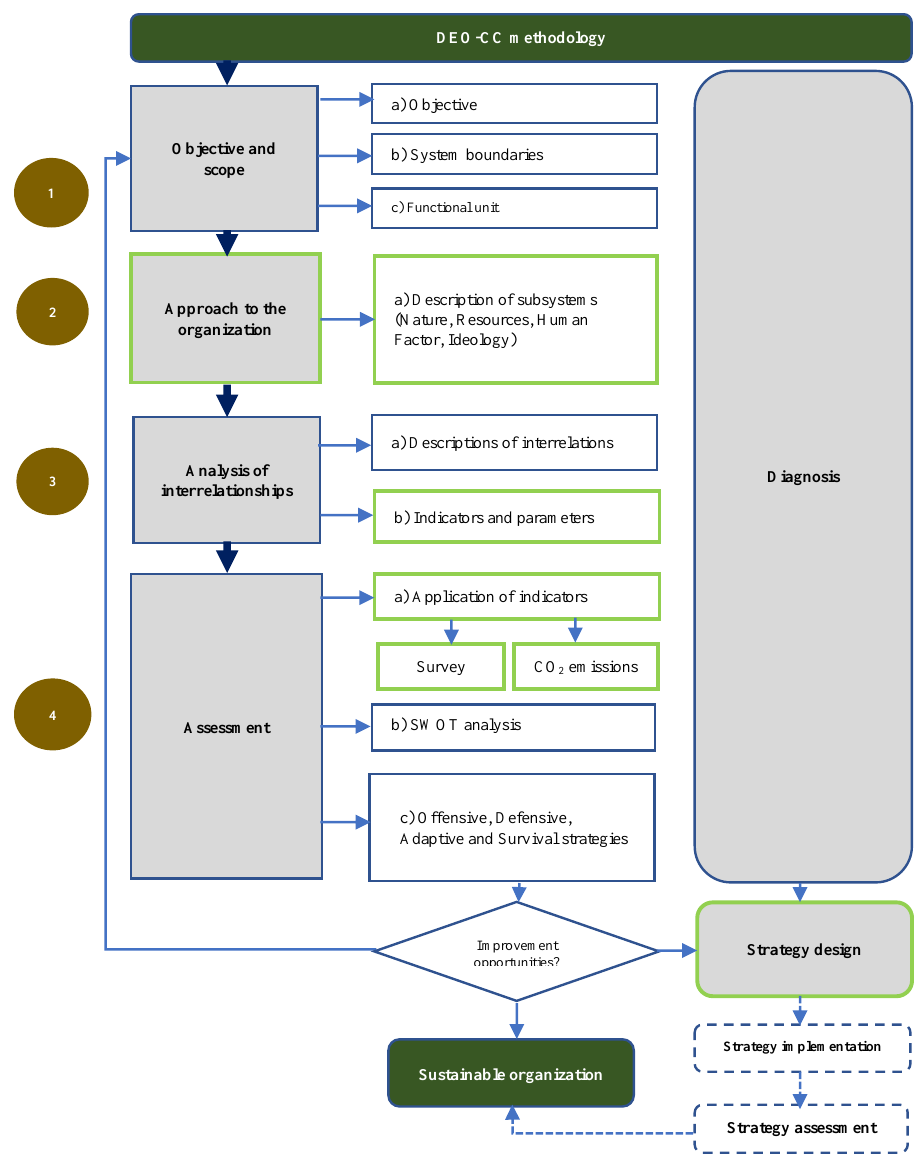
Figure 1. DEO-CC